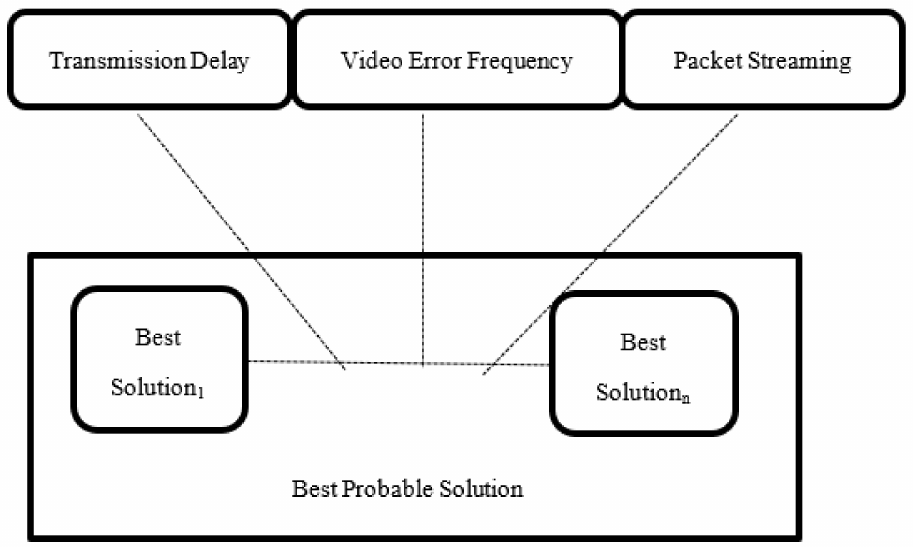
Figure 4. Optimization